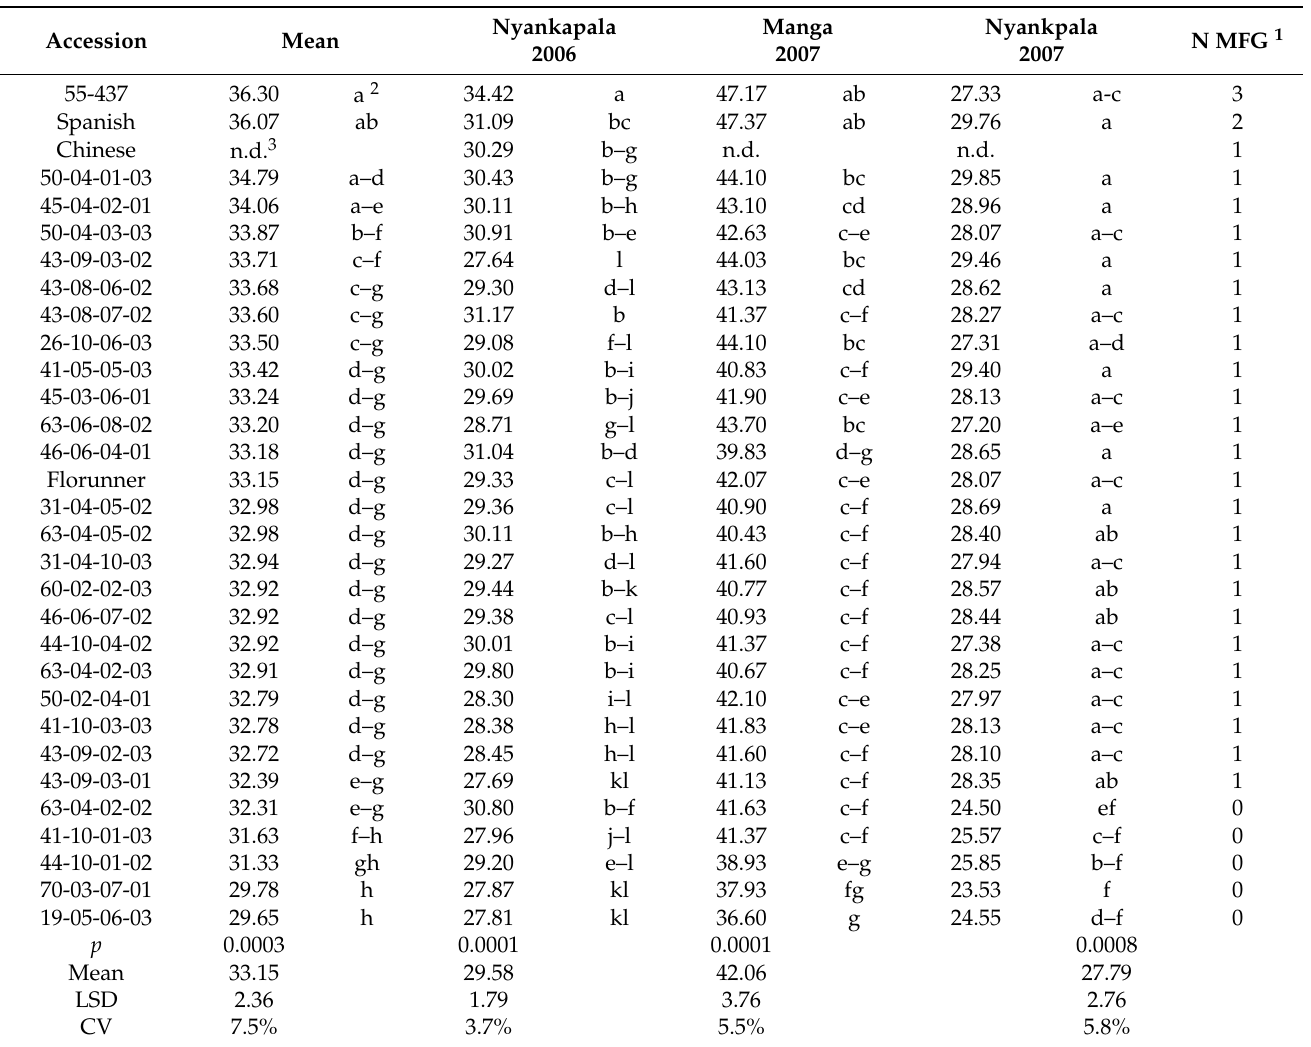
Table 3. Number of days for initial appearance of symptoms of early leaf spot on 50% of